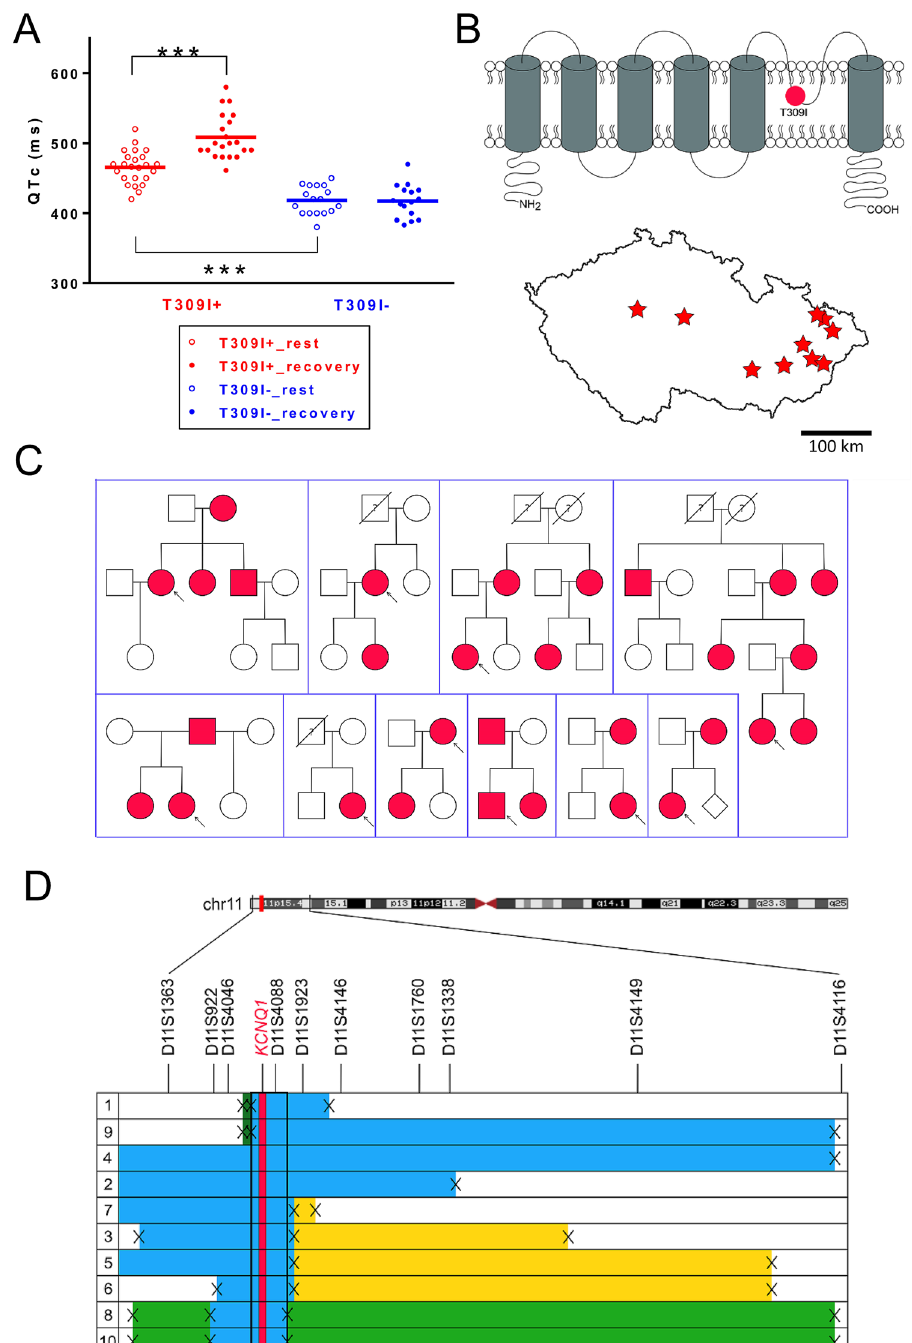
Figure 1. Clinical and genetic characterization of the T309I variant. ( A ) QTc interval length in the heterozygous T309I carriers (T309I +) and their unaffected relatives (T309I-), both at rest and in the 4th minute of exercise test recovery; ***statistical significance at P < 0.001; the graph was prepared using the software GraphPad Prism, version 6.05. ( B ) Scheme of T309I-Kv7.1 subunit (upper panel) and birthplaces of the oldest T309I carriers in every family (lower panel; the map was generated using the software QGIS, version 3.10, with data downloaded from https ://www.arcda ta.cz/produ kty/geogr afick a-data/arccr -500). In the 2 families located in the central part of the country, some earlier ancestors from the eastern part could be identified. Nevertheless, none of them has been living at the time of the study and biological material was not available for molecular analysis. Thus, we can only speculate, whether these ancestors coming from the east really carried the variant, even if it is truly anticipated. ( C ) Family pedigrees; affected individuals in red, probands indicated with arrows. ( D ) Haplotype analysis of the KCNQ1 gene and surrounding regions (analysed STR markers shown in relative distances). The region shared by all affected individuals is framed by bold lines. Families with the same detected haplotype are divided into 3 subgroups (differentiated by colours); presumable ancestral haplotype is shown in blue. The uncoloured parts are unique in every single family; small crosses mark where crossing-overs occurred. Parts B, C, and D were prepared using the software Inkscape, version